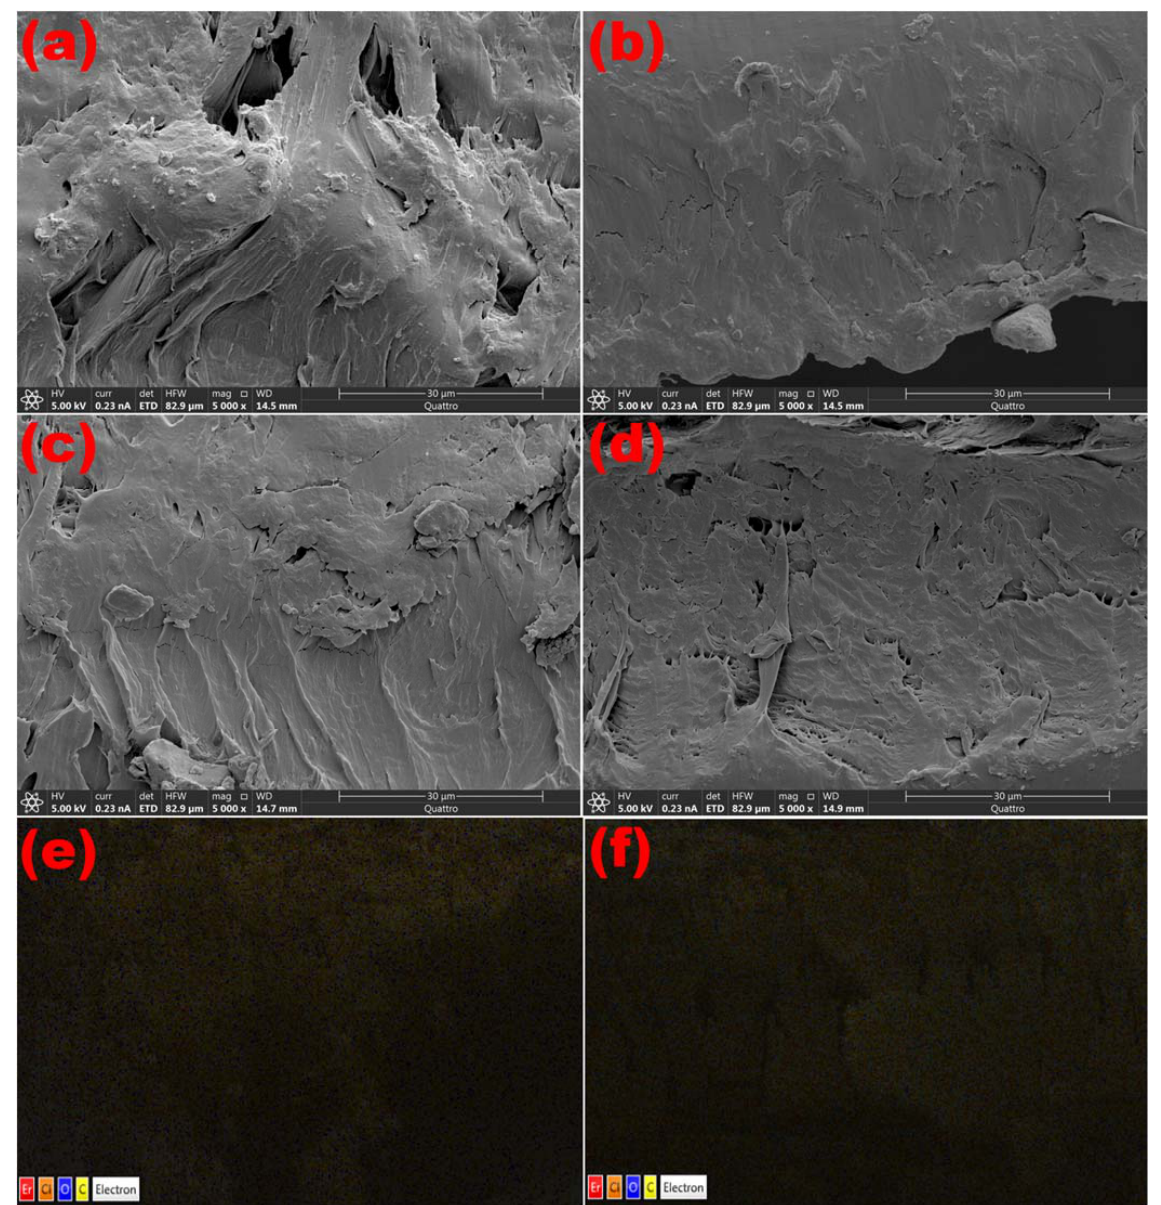
Figure 2. Cross-sectional ESEM scans of PVC/PVP/Er 2 O 3 polymer films at ( a ) 0.0, ( b ) 0.1, ( c ) 0.3 and ( d ) 0.6 wt% and EDS mapping for ( e ) 0.3 and ( f ) 0.6 wt%. The FTIR spectra of the PVC/PVP/Er 2 O 3 blends with different Er 2 O 3 concentrations are shown in Figure 3. At 1650 cm − 1 , the hydroxyl group bending vibrations were identi ‐ fied for all polymer films [26]. The bands at 1322 and 1495 cm − 1 belong to vibrations of C − O and C=C [27]. The bending vibrations of C − H plane verified at positions 684, 833 and 957 cm − 1 [27,28].